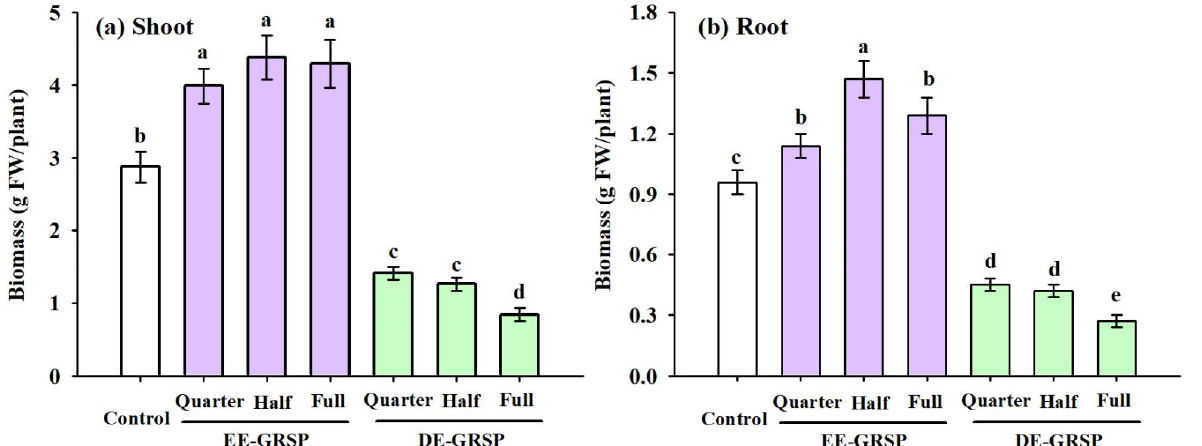
Figure 1. Effect of exogenous EE-GRSP and DE-GRSP on shoot ( a ) and root ( b ) biomass production of trifoliate orange seedlings. Data (mean ± SD, n = 4) followed by different letters above the bars indicate significant differences ( p < 0.05) between treatments.